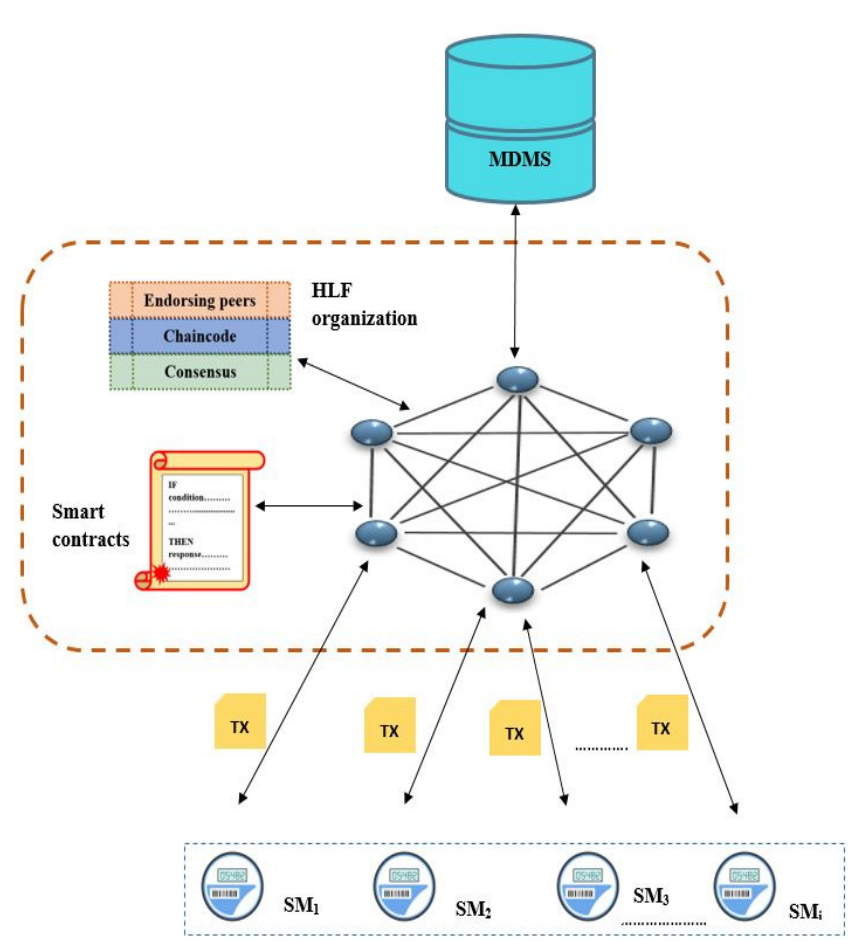
6 of 15 Figure 3. Hyperledger Fabric organization structure integrated with PBFT consensus algorithm. 4. System Methodology 4.1. System Overview